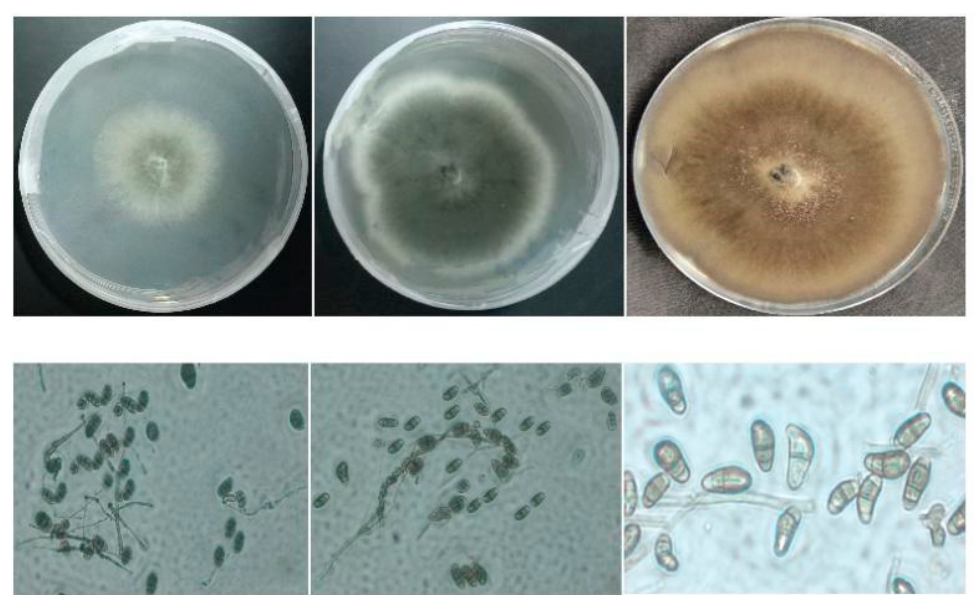
Figure 2. Morphological observations of Curvularia and Bipolaris species on agar plates (Petri dish), and microscopic observations on wet preparation glasses with a zoom of 20 × 10 using a computer microscope.